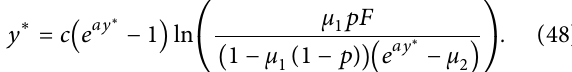
Figure 10: Lyapunov exponent values L calculated from map (36). Parameter values (a) ( μ , μ , p, F,c ) � ( 1 , 0 . 1 , 0 . 8 , 15 , 0 . 5 ) (b) ( μ 1 2